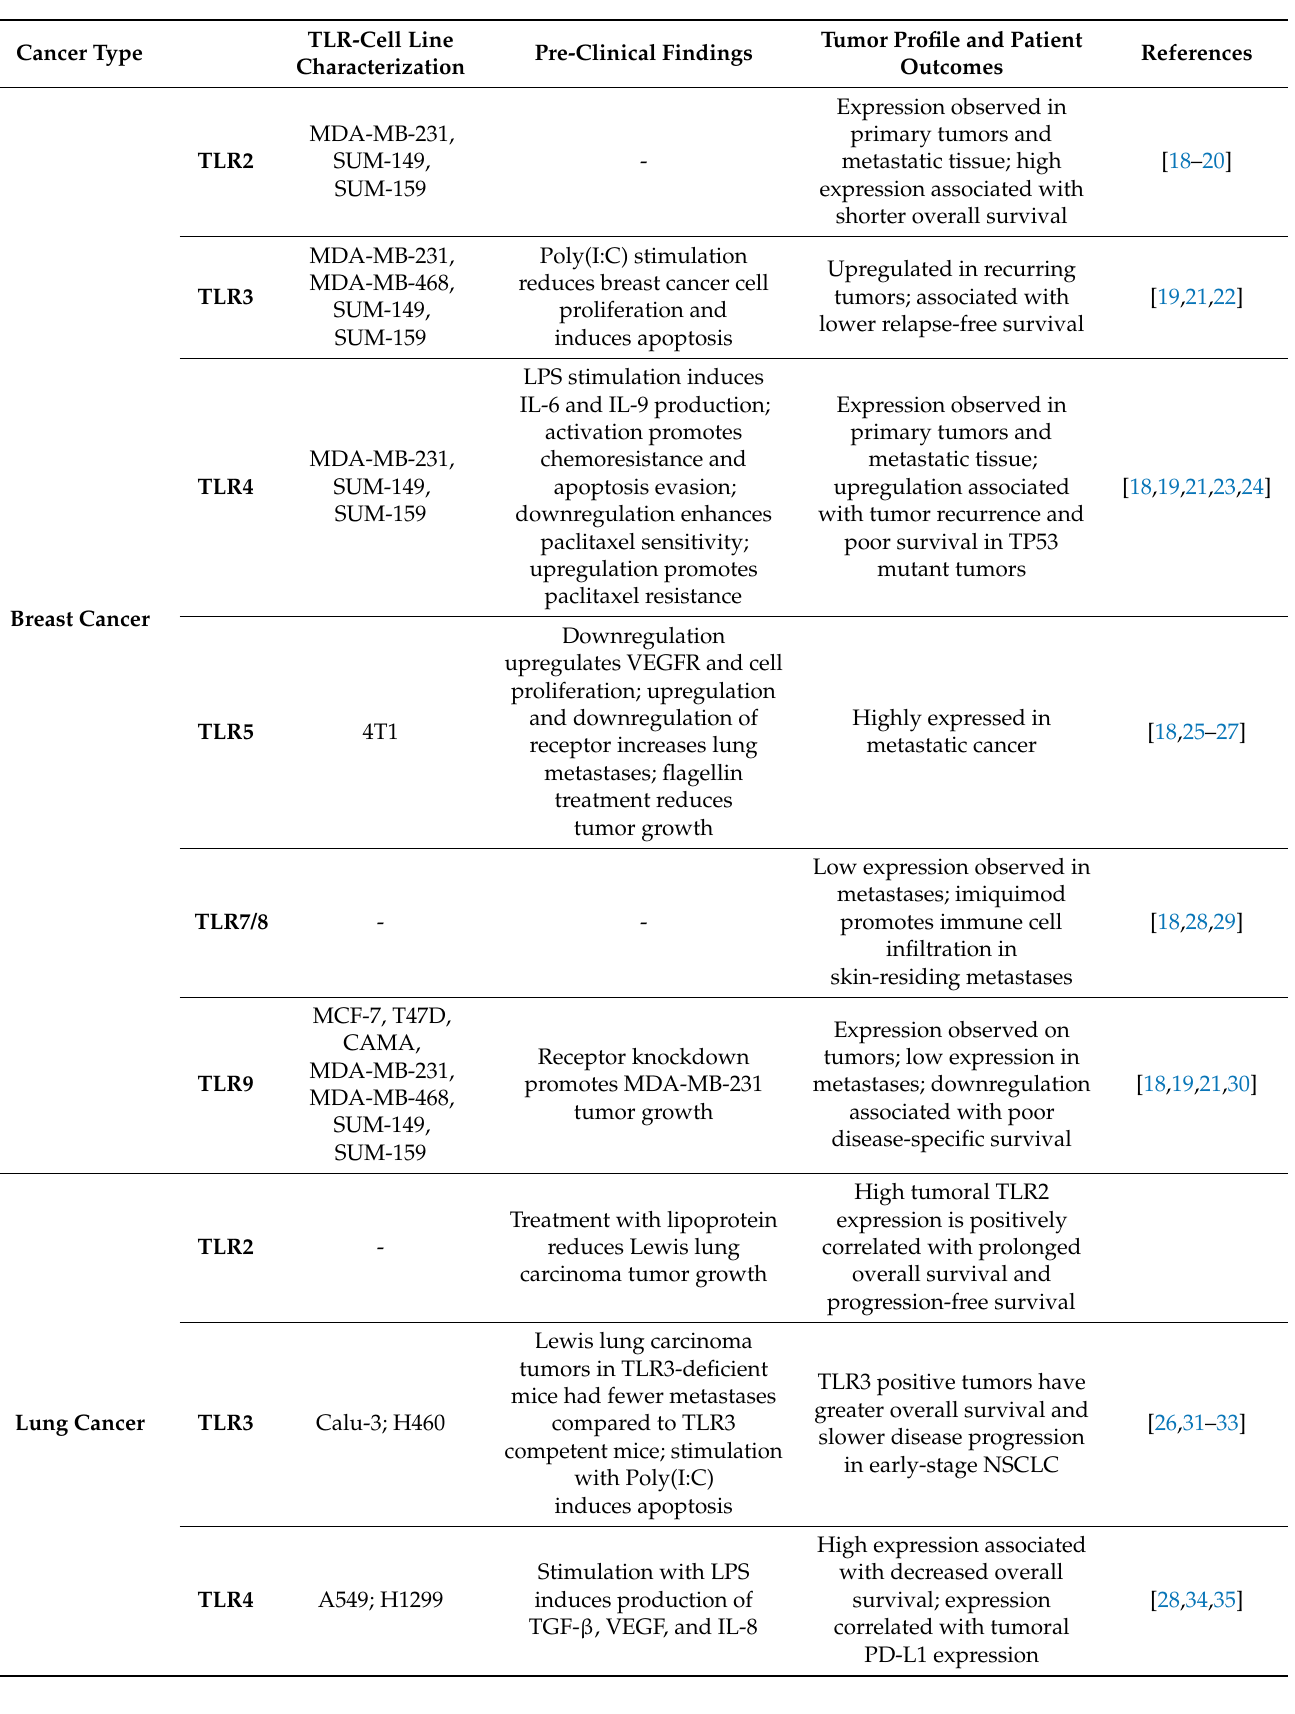
Table 1. TLR Expression and Tumor